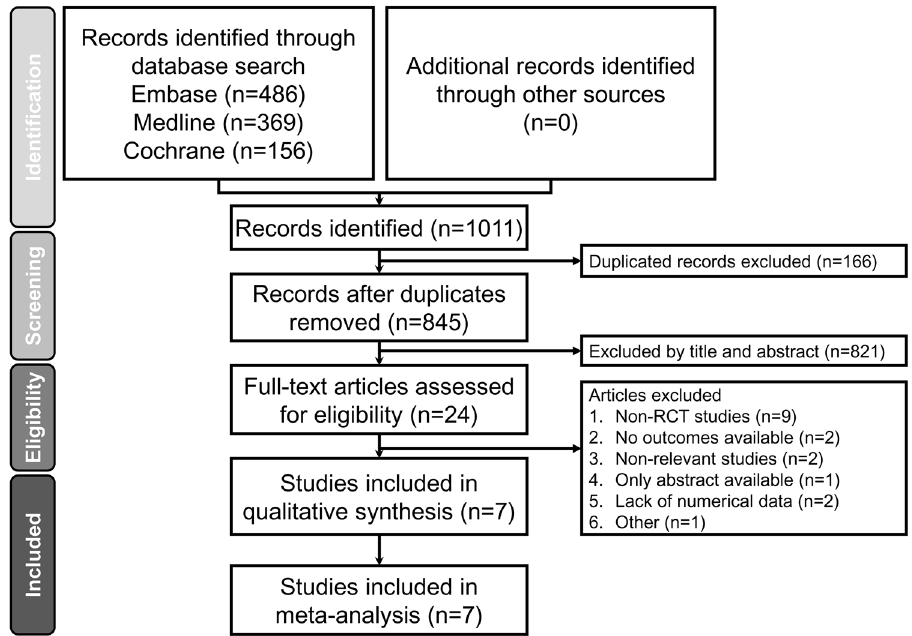
Figure 1. PRISMA flowchart for selecting eligible studies. RCT: randomized controlled